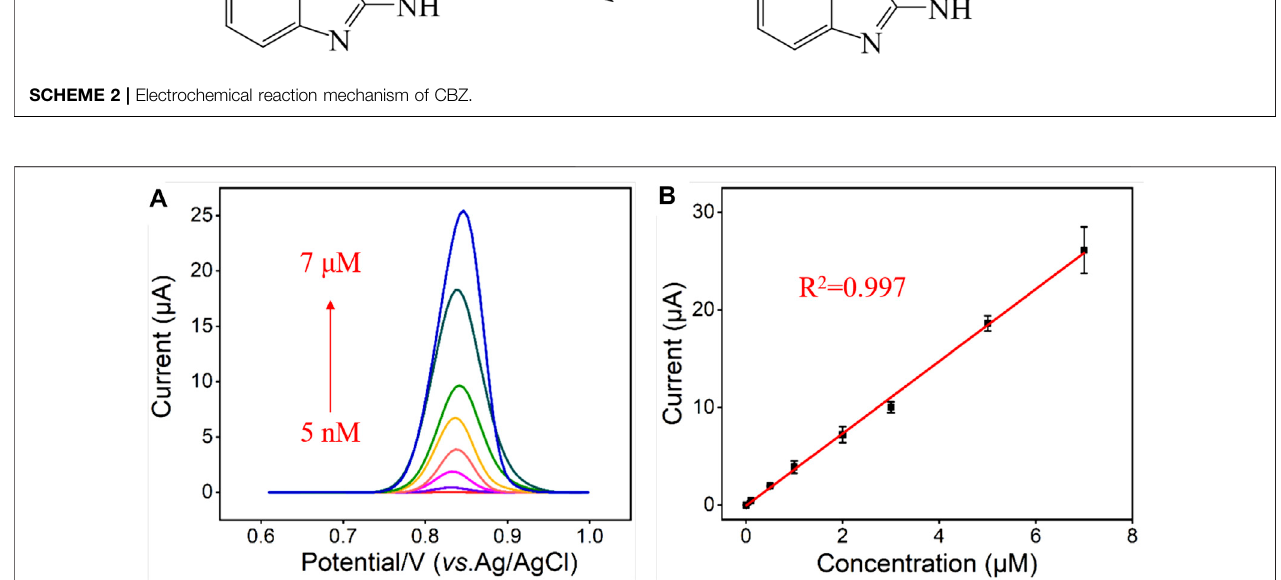
FIGURE 5| (A) DPV curves obtained from the VMSF/BN-rGO/GCE in response to different concentrations ofCBZ (0.005, 0.01, 0.1, 0.5, 1, 2, 3, 5and 7 μ M). The supporting electrolyte is 0.1 M PBS (pH 6.0); Inset is ampli fi ed DPV curves. (B) Calibration plot for CBZ. The error bars represent the standard deviation (SD) of three measurements.